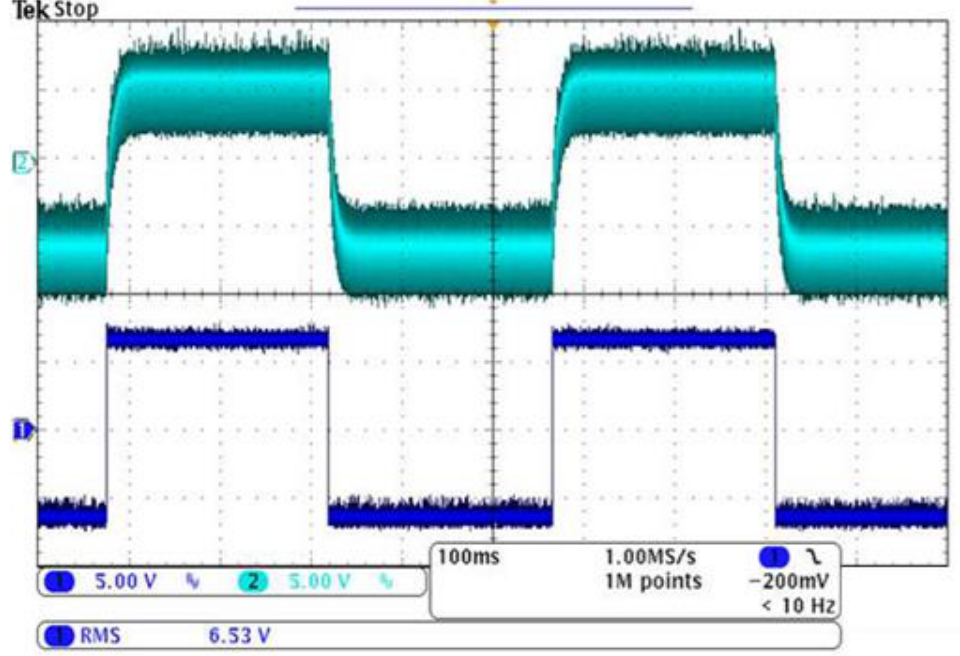
Figure 14. The proposed behavior of the bus current (in light blue), as experimentally tested, corresponding to a given power profile (in blue). For the monitoring signal (light blues) and the command signal (blue) 1 V is equivalent to the 10% of the full